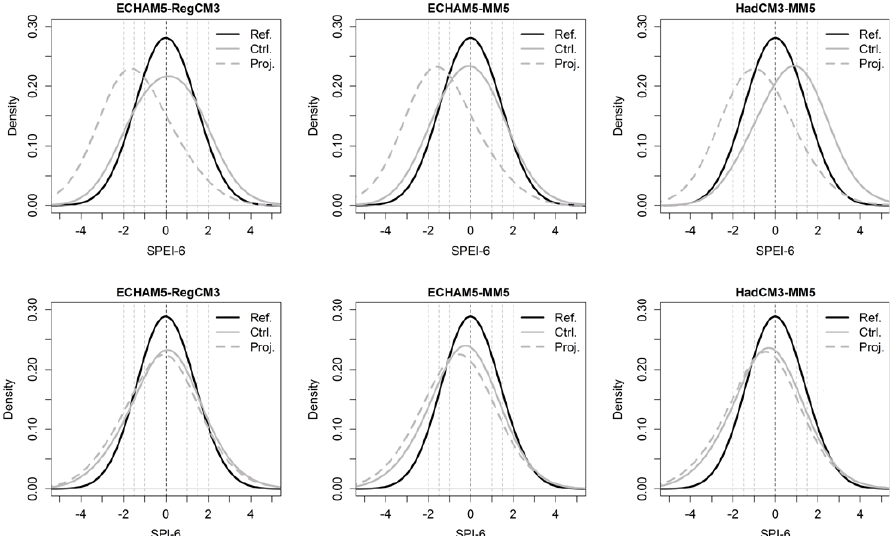
Fig. 7. Probability density functions for the 6-month SPEI (upper row) and the 6-month SPI (lower row). Shown are three GCM/RCM combinations and observed reference data (ref. 1961–1990), the climate model control run (ctrl. 1961–1990) and a future projection (proj. 2031–2060). The negative vertical lines indicate the thresholds for moderate, severe and extreme drought conditions.